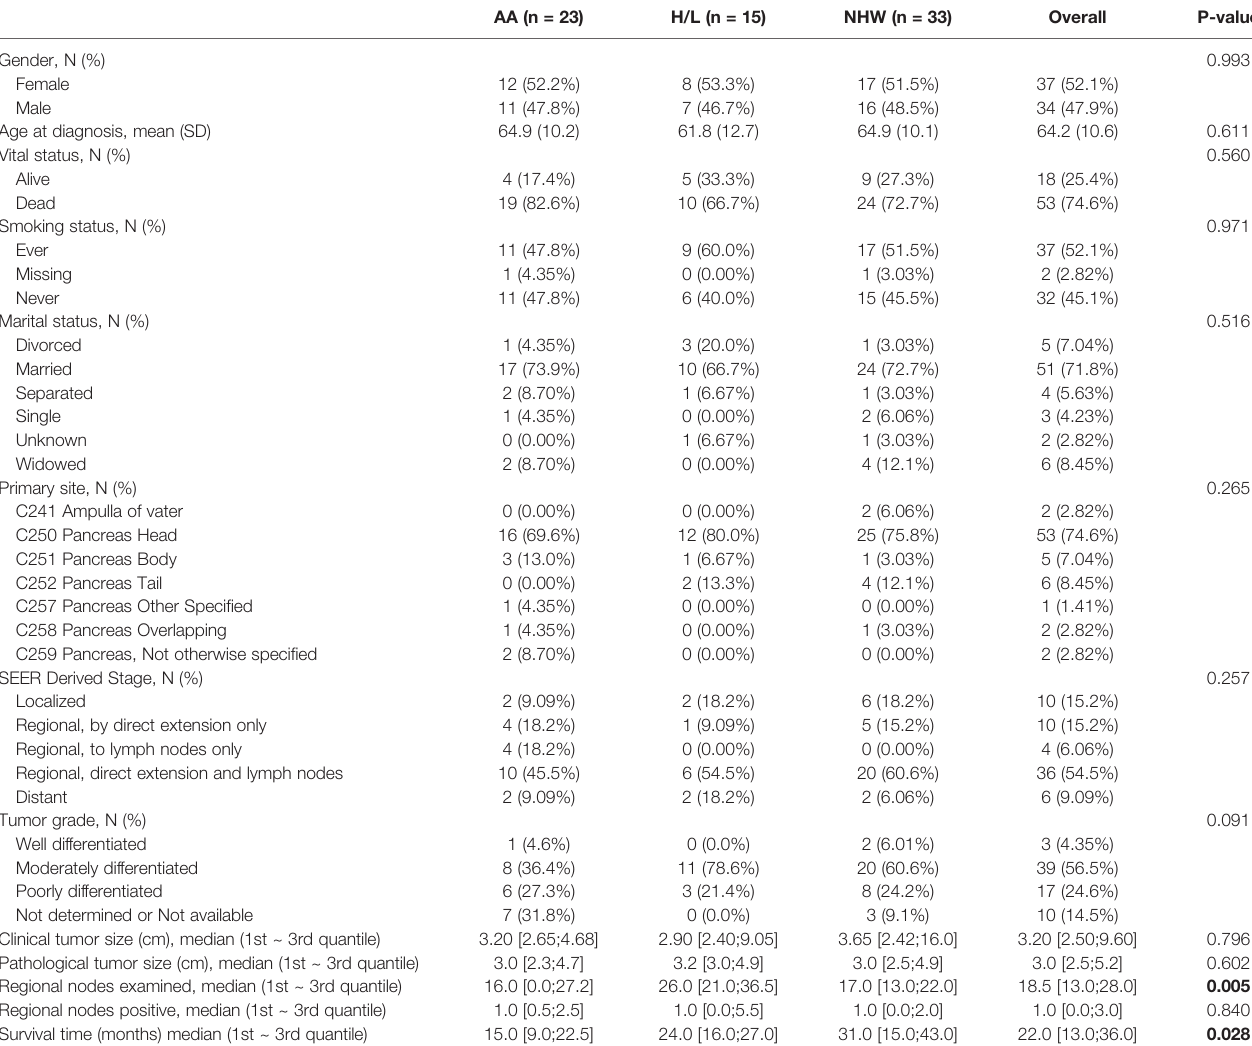
TABLE 1 | Select demographic and clinical characteristics of the pancreatic ductal adenocarcinoma CT radiomic study cohort